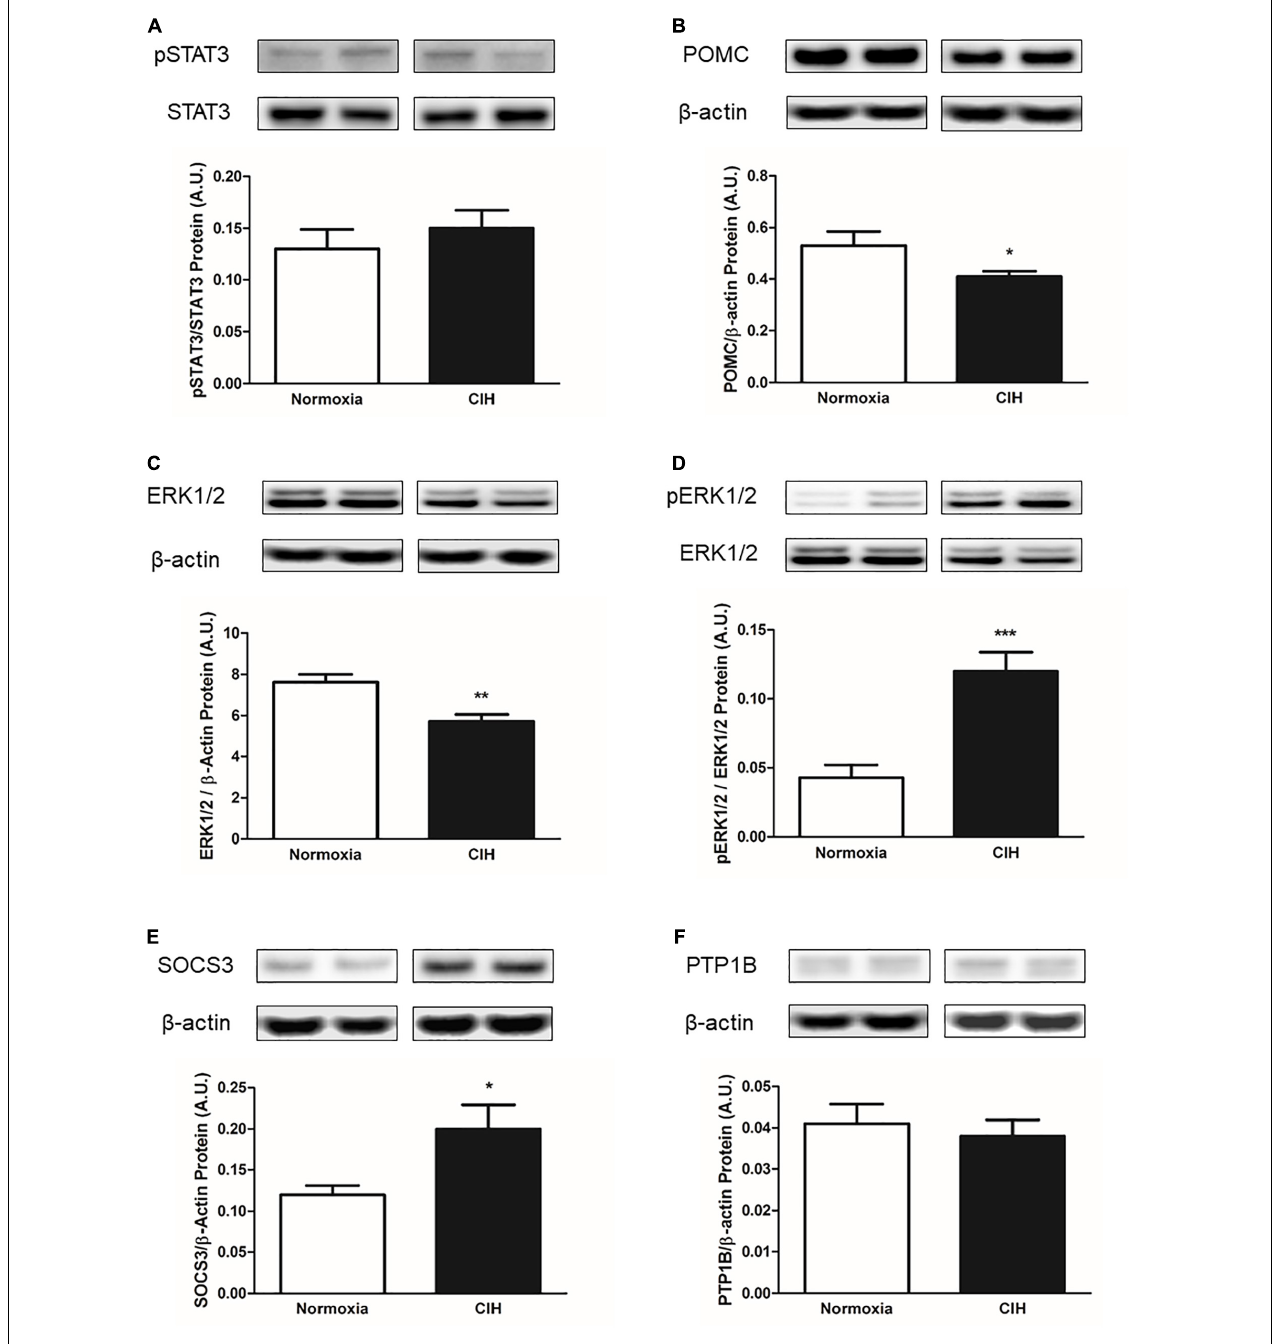
FIGURE 7 | Representative western blots and bar charts depicting pSTAT3/STAT3 (A) protein expression, POMC (B) protein expression, total ERK1/2 protein expression (C) , pERK1/2/ERK1/2 (D) , and inhibitors of leptin signaling SOCS3 (E) and PTP1B (F) protein expressions within the ARC. Note that CIH decreases the expression of the leptin signaling protein POMC and ERK1/2, while increasing the expression of pERK1/2 within the ARC. Also note that CIH increases the expression of SOCS3, but not the PTP1B protein expression after 96 days exposure. Data are presented as mean ± standard error. * p < 0.05, ** p < 0.005, and *** p < 0.001. n = 10 per